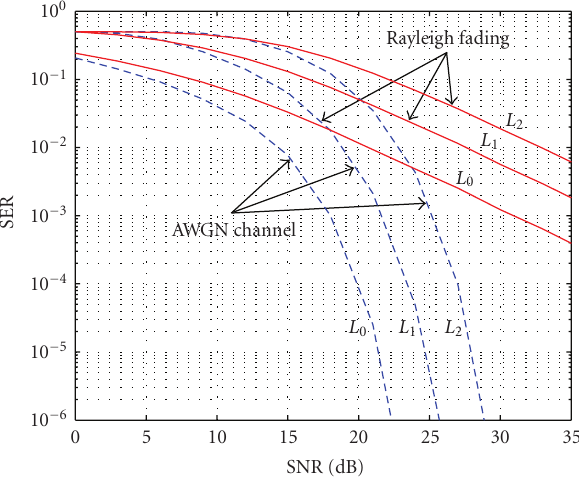
Figure 2: SER performance for 2/4/8 hierarchical QAM (defined in Figure 1(b)) assuming 3 di ff erent classes with a margin separation of 3dB. In total, 6144 bits were placed on 2048